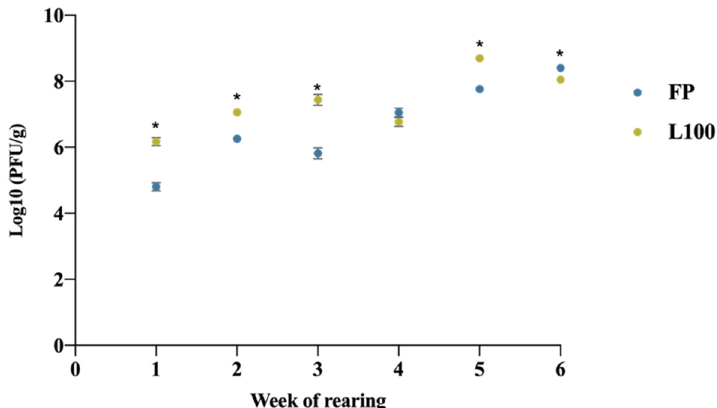
Figure 4. Concentration of the BPs found in faeces depending on the week of application. Values are presented as Log10 (PFU/g). FP: free BP; L100: encapsulated BP with the polymer Eudragit ® L100. The statistically significant differences between groups comparing BP delivery method have been represented as * ( p -value < 0.05).